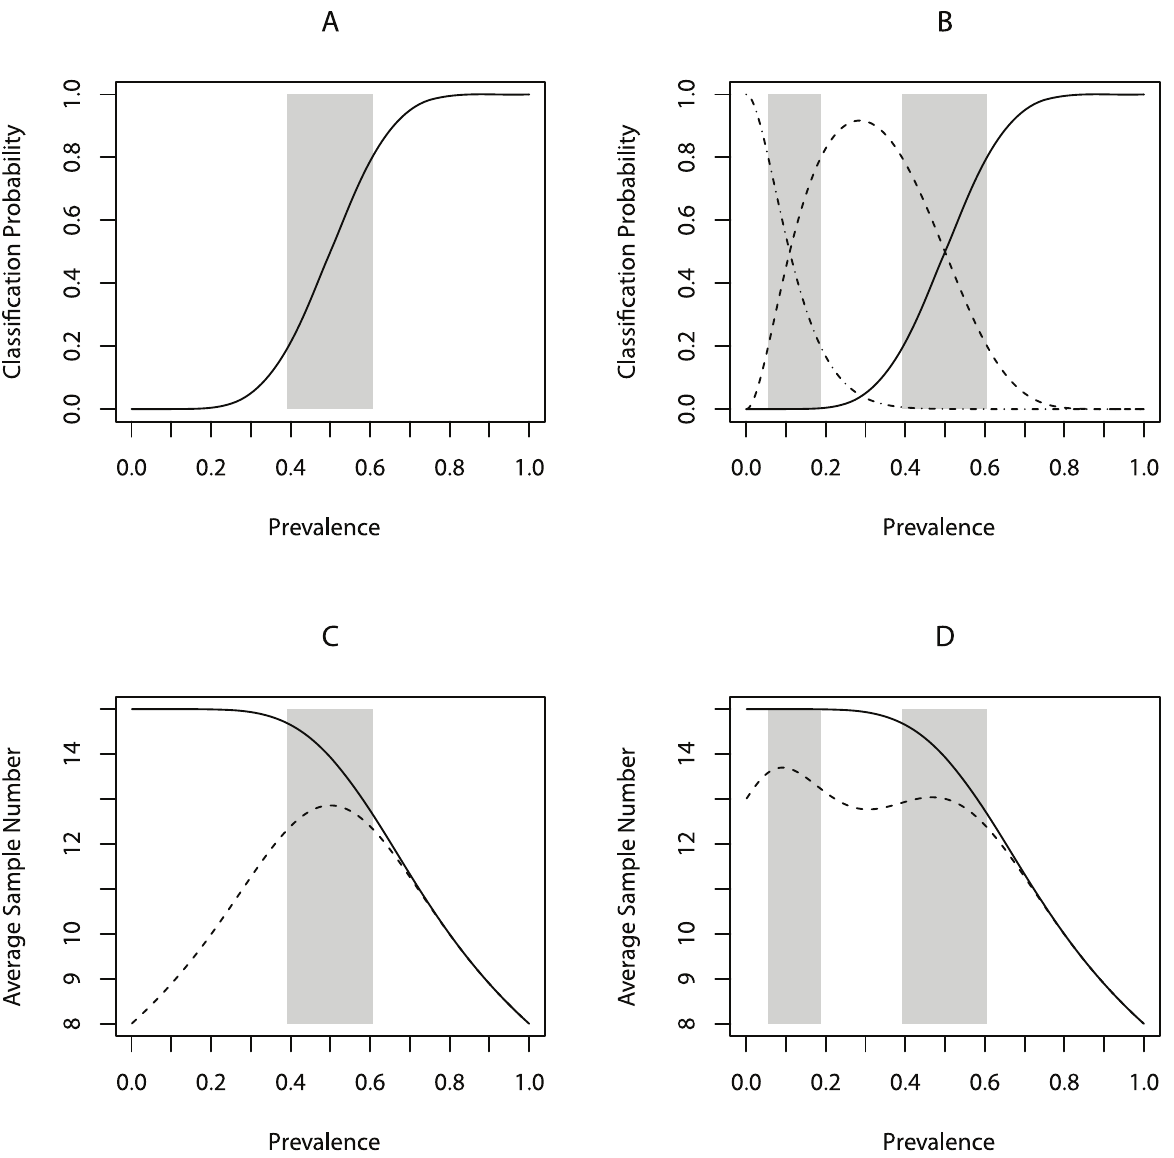
Figure 1. Operating Characteristic curves and Average Sample Number for LQAS and MC-LQAS. A) Operating Characteristic curve for LQAS design with n=15,d=7, and a = b =0.20; B) Operating Characteristic curves for low (dashed-dotted), medium (dashed), and high (solid) categories for MC-LQAS design with n=15, d 1 =1, d 2 =7, and d 1 = d 1 = d 1 = d 1 =0.20; C) Average Sample Number for semi-curtailed (solid) and curtailed (dashed) LQAS with n=15 and d=7; D) Average Sample Number for semi-curtailed (solid) and curtailed (dashed) MC-LQAS with n=15, d 1 =1, and d 2 =7.